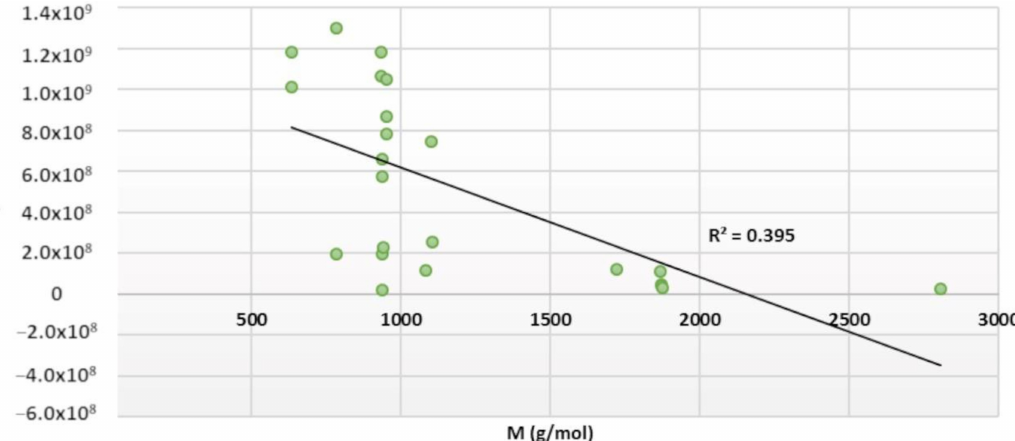
Figure 5. The e ff ect of the molecular size of ellagitannin on its antimicrobial strength against E. coli (24 h treatment with 0.5 mM tannin solution). A linear regression model was